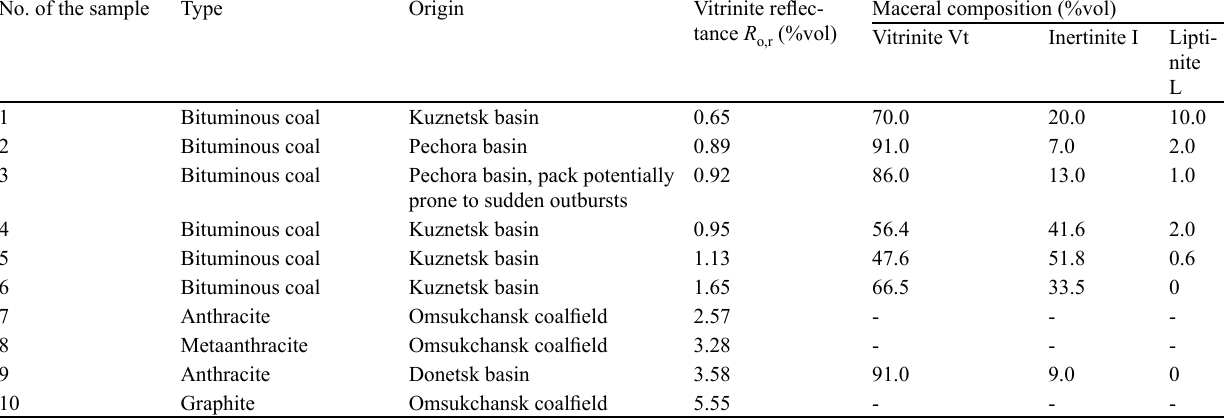
Table 1 Characteristics of coals samples used in the research No. of the